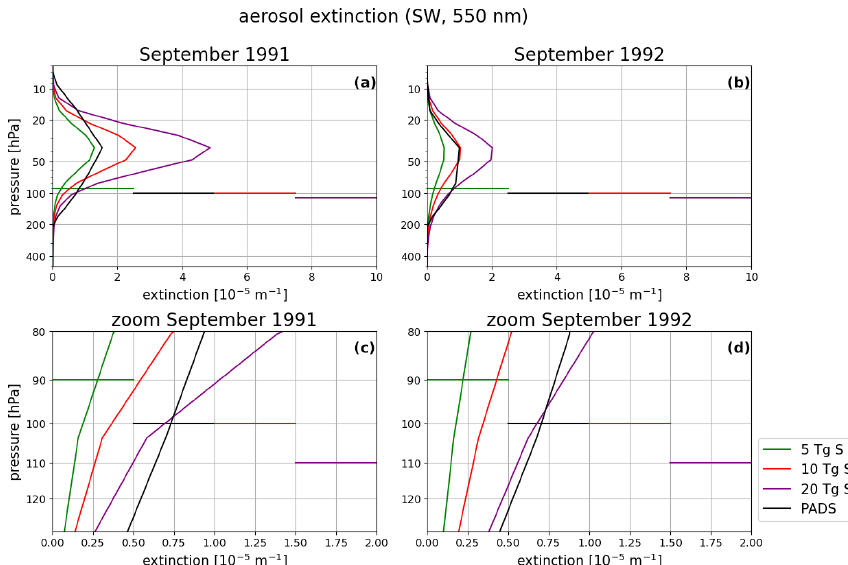
Figure D1. Tropical average of the aerosol extinction profile in the 550nm solar waveband for the EVA forcing corresponding to 5, 10 and 20Tg S as well as the PADS forcing for the Mt. Pinatubo eruption.